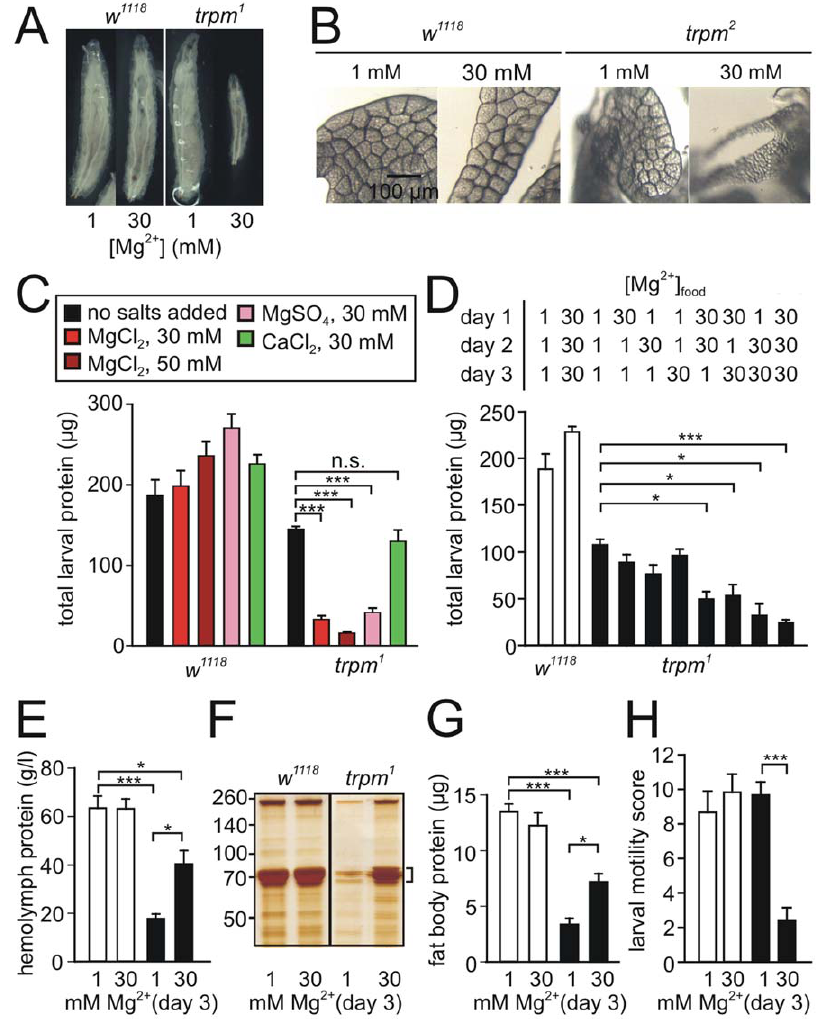
Figure 2. Impact of dietary Mg 2 + on larval growth in the trpm mutant. (A) Sizes of larvae after feeding for three days on food containing 1 or 30 mM total Mg 2 + . (B) Fat bodies dissected from w 1118 and trpm 2 3 rd instar larvae fed on either 1 mM or 30 mM Mg 2 + . (C) Summary of total larval protein per larvae after 80 hrs on media supplemented with the indicated divalent cation salts (n=5 2 10). (D) Sensitivity of trpm larvae ( trpm 1 ) to the duration of Mg 2 + exposure. Larvae were kept in media containing 1 or 30 mM MgCl 2 for 1–3 days as indicated. (E) Hemolymph protein content in larvae exposed to low and high levels of MgCl 2 (white bars, Canton S; black bars, trpm 2 ). (F) Detection of hemolymph proteins by silver staining after by SDS-PAGE fractionation of the equivalent of 160 nl of hemolymph in each lane. Protein sizes markers are indicated to the left (kDa) and the bracket indicates the LSP proteins/hexamerins. (G) Protein content in the fat bodies microdissected from 3 rd instar larvae after being maintained on day 3 on either 1 or 30 mM Mg 2 + . (H) Effect of 1 day of exposure to elevated Mg 2 + on the locomotive performance of w 1118 and trpm 1 larvae. 3 rd instar larvae were allowed to move freely on a 2% agar field demarcated with a projected 1 cm grid. We then assayed the number of lines crossed after 3 min (n=5 2 6 each, mean + / 2 SEM). The level of statistical significance of the difference between groups is indicated above the bars (*, p , 0.05; ***, p , 0.001, n.s. not significant).